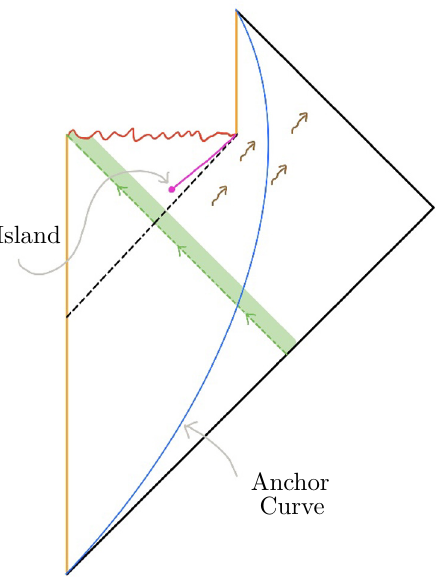
Figure 2 . Penrose diagram of an evaporating RST black hole formed from collapsing matter (green). A timelike anchor curve separates the spacetime into interior and exterior regions. As time evolves along this curve, more and more Hawking radiation has passed through it on its way to future null infinity. The island moves with time along the purple curve inside the event